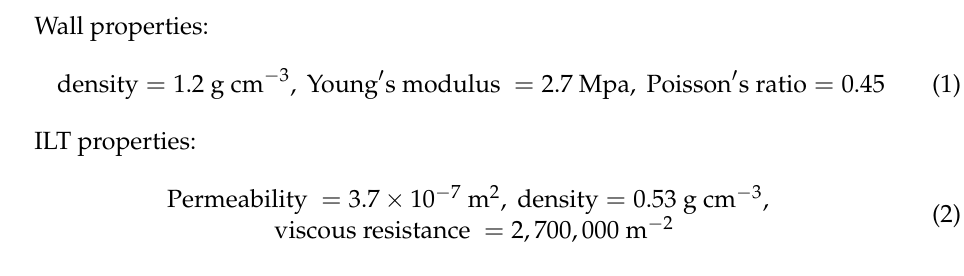
4 of 12 Figure 3. Meshed model. 2.3. Material Properties The geometry consisted of three bodies: the aneurysm walls as a solid material, the ILT as a porous material, and the lumen as a fluid material for the flow of oxygen and